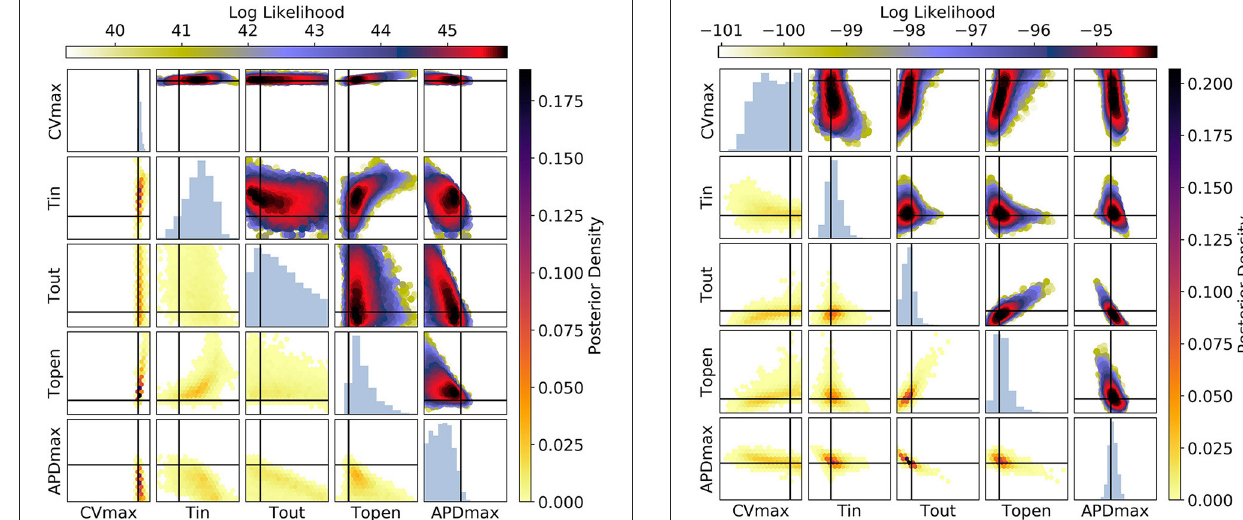
FIGURE 10 | The posterior parameter distribution for fits to CV(S2) and ERP(S1) measurements. The intersection of vertical and horizontal lines mark the true parameter value. The lower diagonal shows the density via hexbin plots, while the upper diagonal shows the log likelihood values for each sample plotted in order of increasing likelihood. The diagonals show the marginal histograms of each parameter.